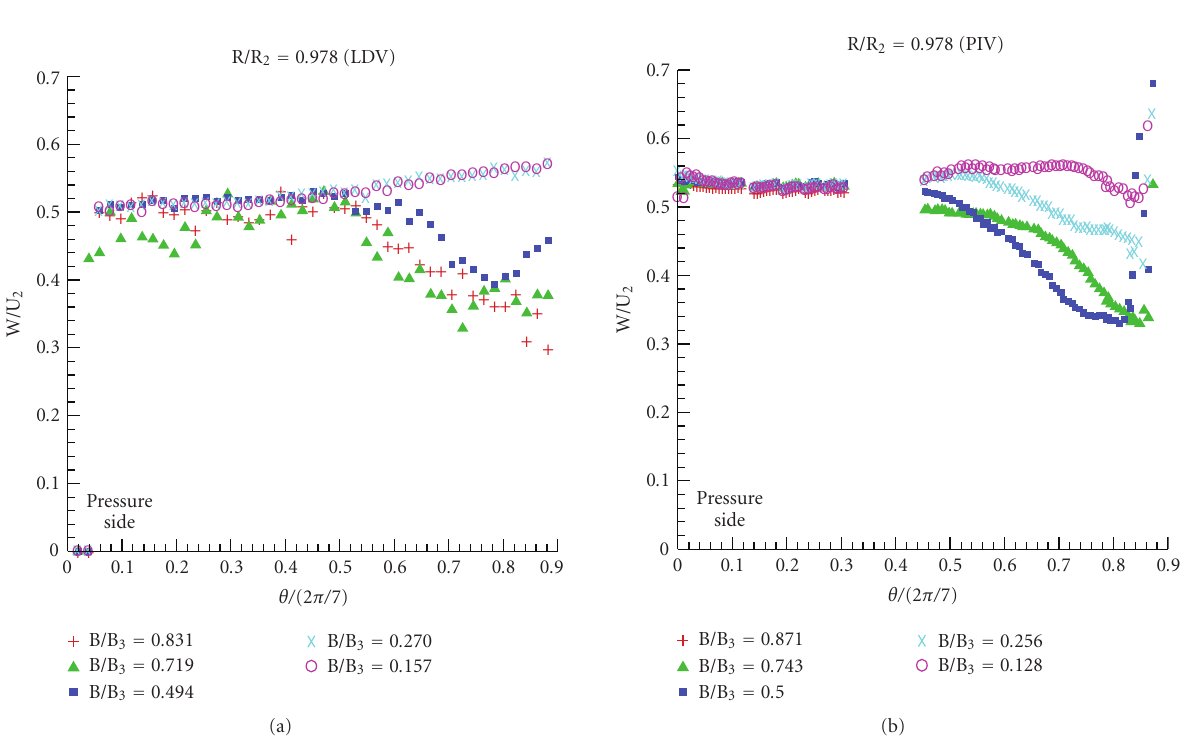
Figure 4: Evolutions of W/U 2 in the blade-to-blade direction at a constant radius r ∗ = 0 .